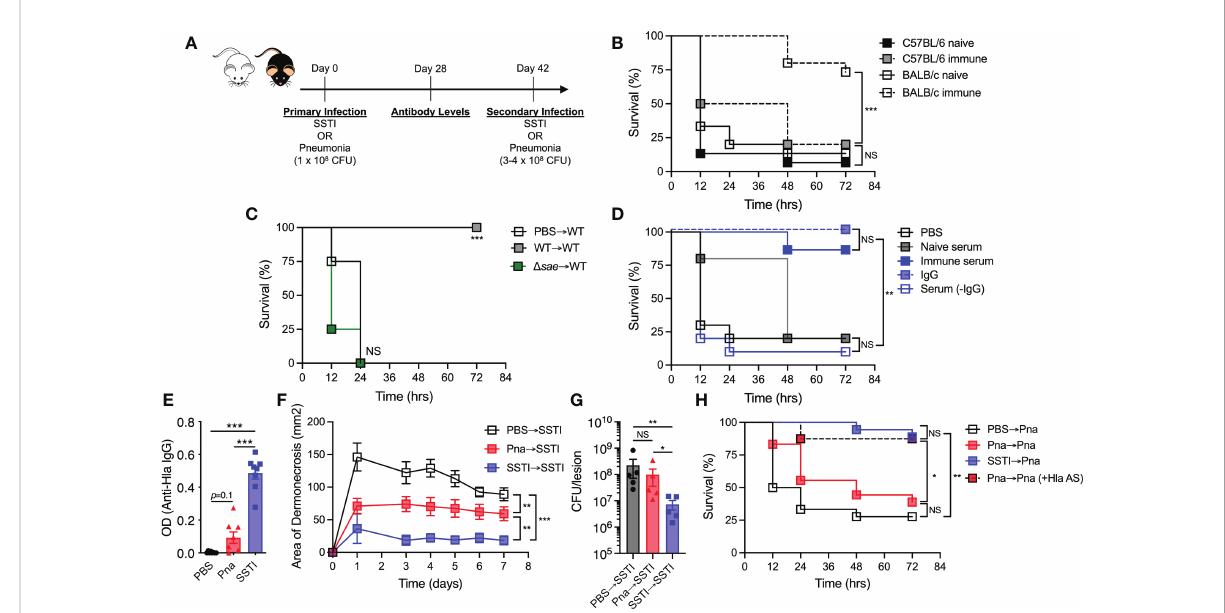
FIGURE 1 S. aureus SSTI, but not pneumonia, elicits antibody-mediated protection against secondary SSTI and pneumonia. (A) Model of recurrent SSTI and pneumonia. On day 0, mice were infected with S. aureus skin infection (SSTI) or pneumonia (sublethal inoculum, 1 x 10 8 CFU), followed by quanti fi cation of antibody levels 4 weeks later and reinfection with SSTI or high-dose pneumonia (3-4 x 10 8 CFU) 6 weeks later. (B) SSTI protected BALB/c mice, but not C57BL/6 mice, against secondary pneumonia. (C) Expression of saeRS was necessary to elicit protection against secondary pneumonia in BALB/c mice. (D) Passive transfer of serum from previously infected BALB/c mice ( “ immune ” ) was suf fi cient to protect against pneumonia. Puri fi ed IgG from immune serum protected against pneumonia, but serum from which IgG was removed (Serum (-IgG)) did not. (E) There were increased levels of anti-Hla IgG in BALB/c mice following SSTI (4 weeks post-infection), compared with pneumonia. (F) Primary SSTI elicited stronger protection against secondary dermonecrosis, compared with primary pneumonia. (G) Primary SSTI, but not primary pneumonia, resulted in enhanced clearance of bacteria from skin lesions. (H) Primary SSTI, but not primary pneumonia, protected against secondary pneumonia. Passive transfer of Hla-speci fi c antiserum (AS) rescued protection in mice that received primary pneumonia. (F, G) N=5 mice/group from one representative experiment (of 2 performed). (B – E, H) N=8-15 mice/group pooled from 2-3